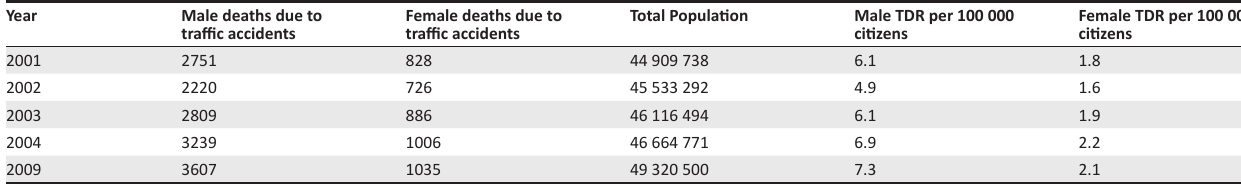
TABLE 4: The gender-segregated TDR values.